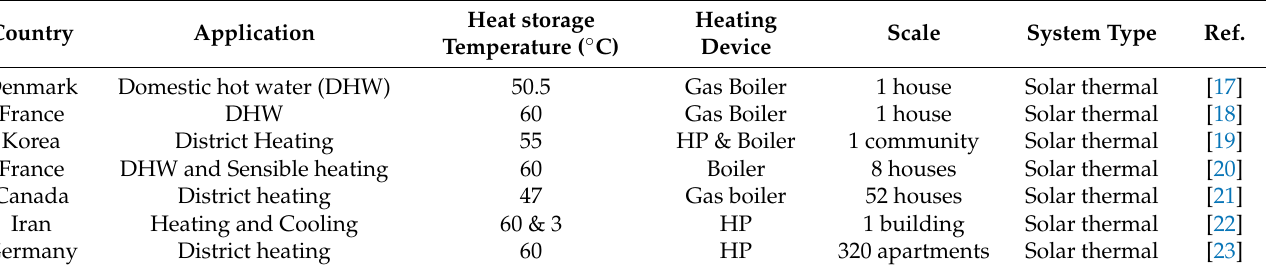
Table 2. Commercial projects for sensible heat